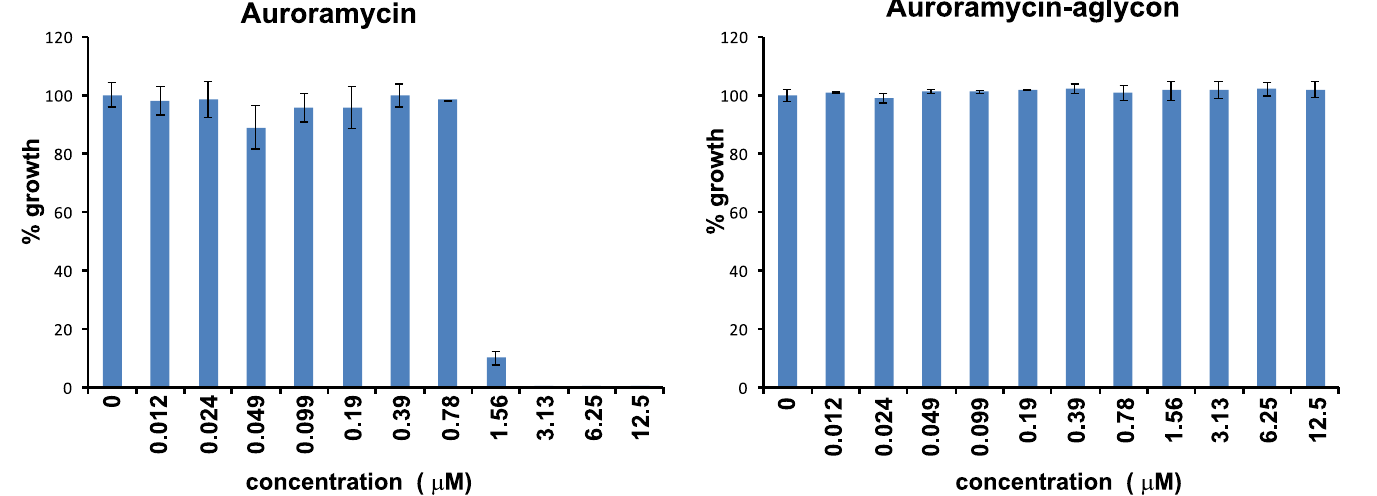
Fig 2. Auroramycin but not its aglycon derivative inhibits the growth of Saccharomyces cerevisiae . Yeast cells were exposed to auroramycin and its aglycon at the indicated concentrations in duplicates in a 96-well microplate. Cell growth was quantified by recording the absorbance at 600 nm after 24 hours. Growth (normalized with respect to DMSO-treated cells) is plotted against concentration of the compounds. Error bars (n = 2 Mean ± S.D) are indicated in the